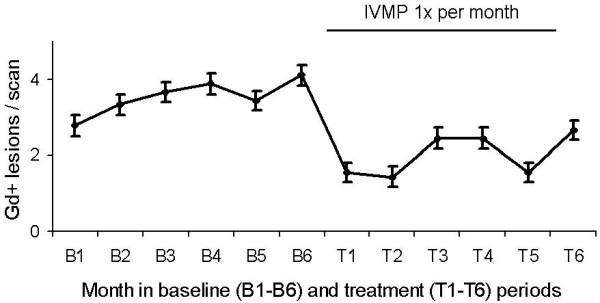
Time course of the mean number of active lesions on monthly Gd-enhanced brain MRI.